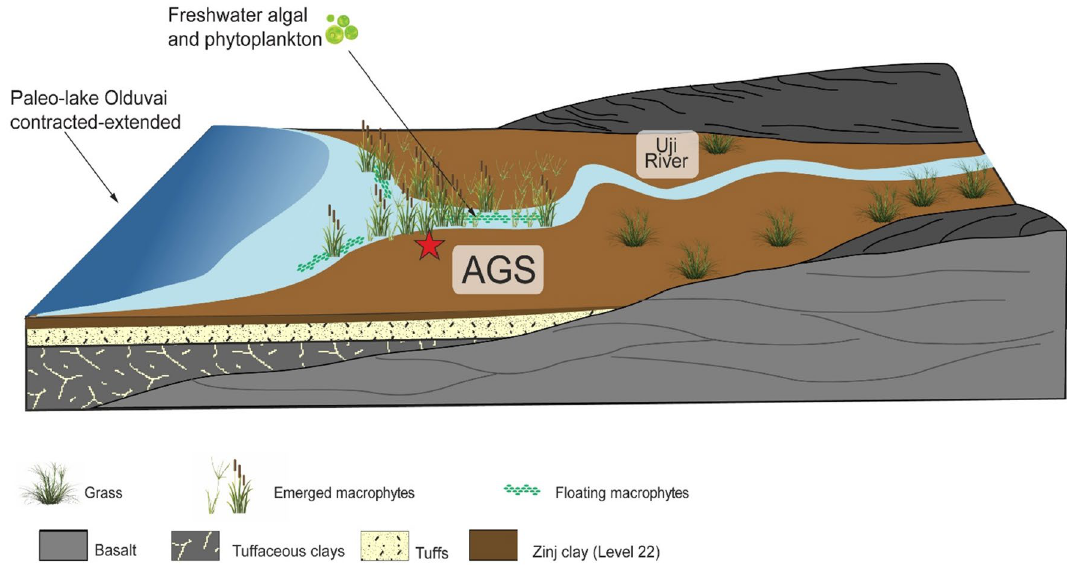
Figure 7. Graphical three-dimensional geomorphological reconstruction of the syndepositional Zinj level 22A horizon at AGS between two lava tongues and Uji River. AGS was located near a river and the main vegetation inputs were from emerged macrophytes, floating macrophytes, freshwater algal and phytoplankton. This figure was made using Adobe Creative Suite 6 for Windows https:// www. adobe.